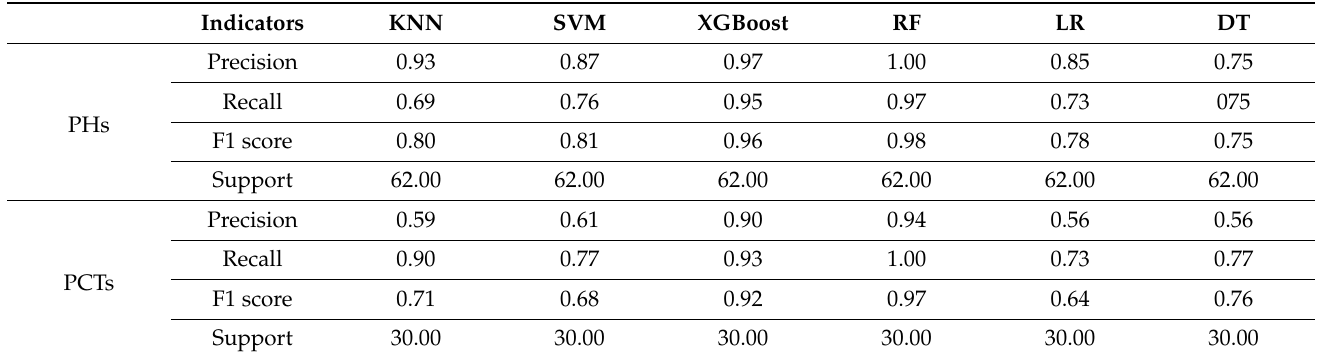
Table 3. Results of the four indicators of precision, recall, F1 score, and support based on the test data using the first model.